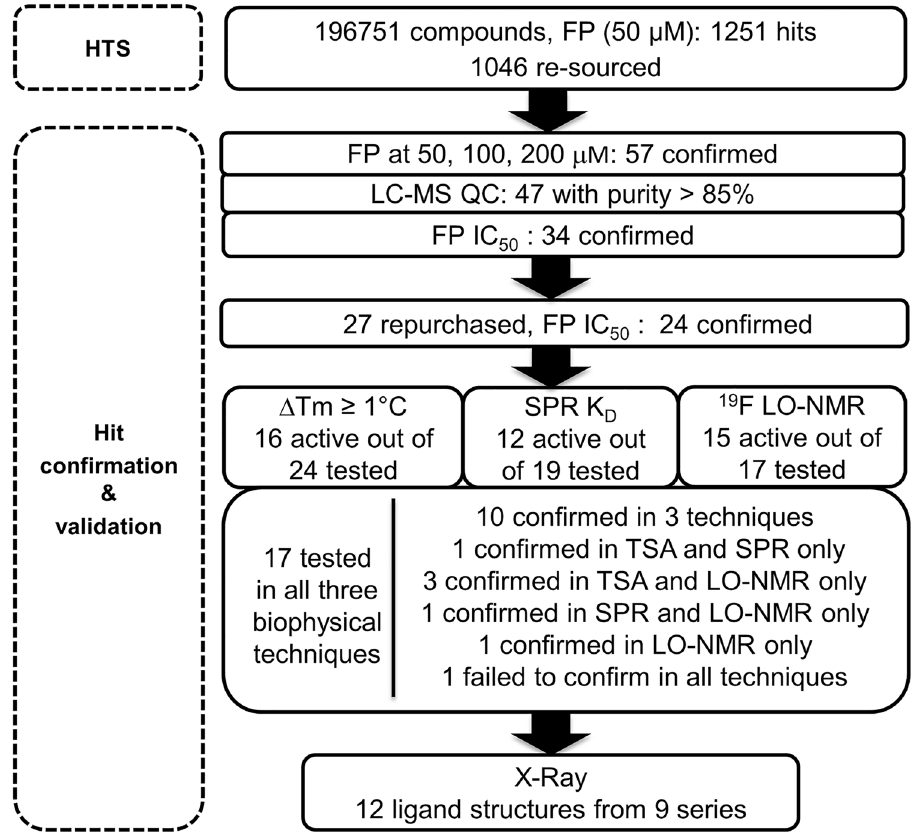
Figure 1. Summary of HTS campaign and hit validation by orthogonal biophysical techniques. An HTS was carried out using an FP assay with an FP-probe based on a BCOR corepressor peptide. The primary HTS hits were subjected to a first confirmation step at three concentrations in the FP assay. Hits confirmed in this step were progressed to IC 50 determination in the FP assay using repurchased material. Active hits were characterised in orthogonal biophysical techniques including TSA, SPR and LO-NMR using a 19 F-labelled WVIP reporter peptide. Compound selection for the respective biophysical assays was heavily based on experimental aqueous solubility experiments on the confirmed hits using NMR and HPLC. Hits confirmed to bind the BCL6-BTB domain in one or more biophysical methods were selected for binding mode elucidation by X-ray crystallography which yielded 12 protein–ligand structures representing 9 different chemical